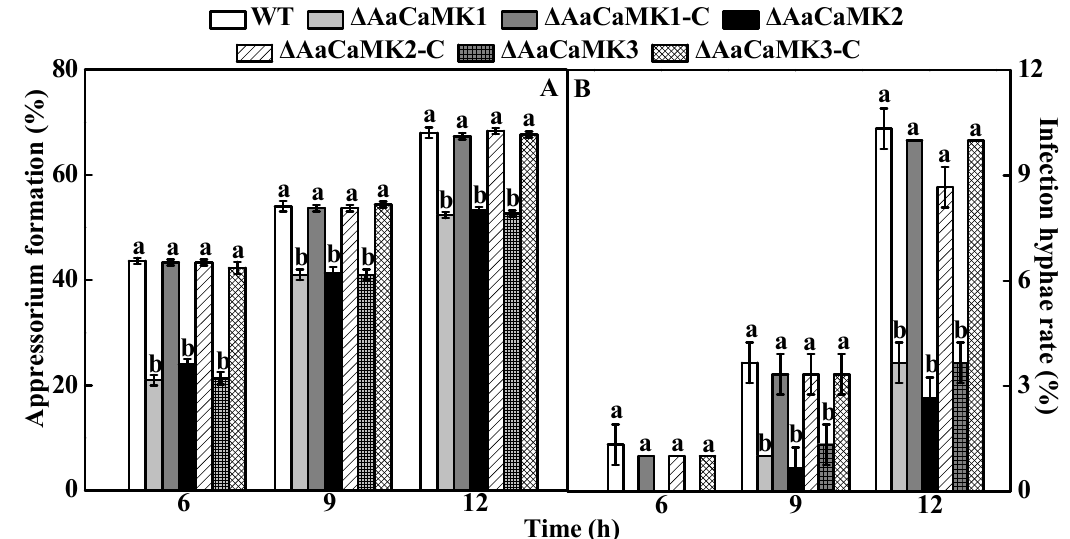
Figure 7. The A. alternata appressorium ( A ) and infection hyphae ( B ) formation on intact pear epidermis. Vertical lines indicate standard error ( ± SE). Different letters indicate significant differences ( p < 0.05).